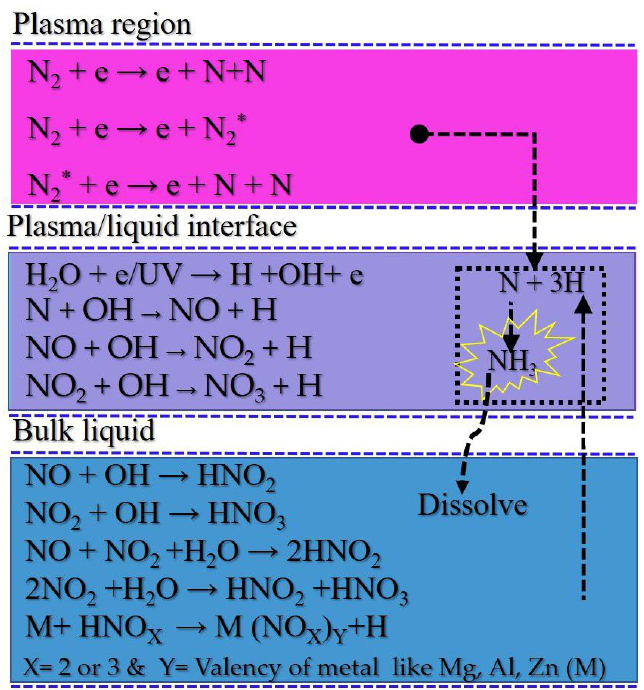
Figure 10. Chemical pathways of plasma-assisted nitrogen fixation and acid